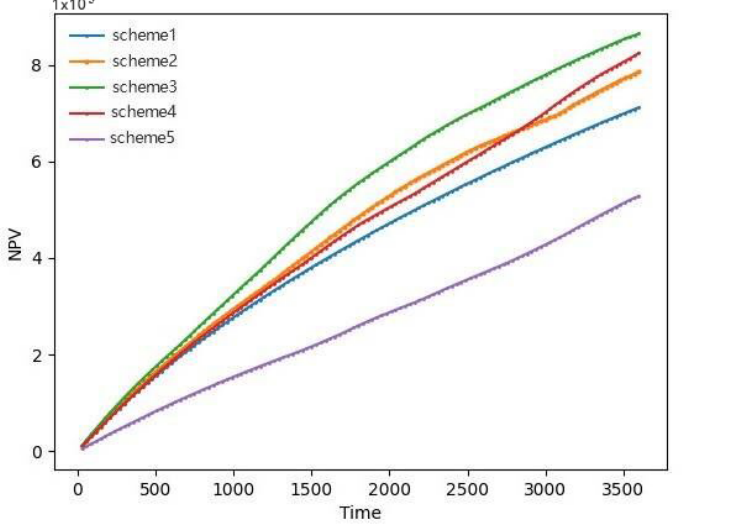
Figure 9. Changes in the NPV under different injection-production